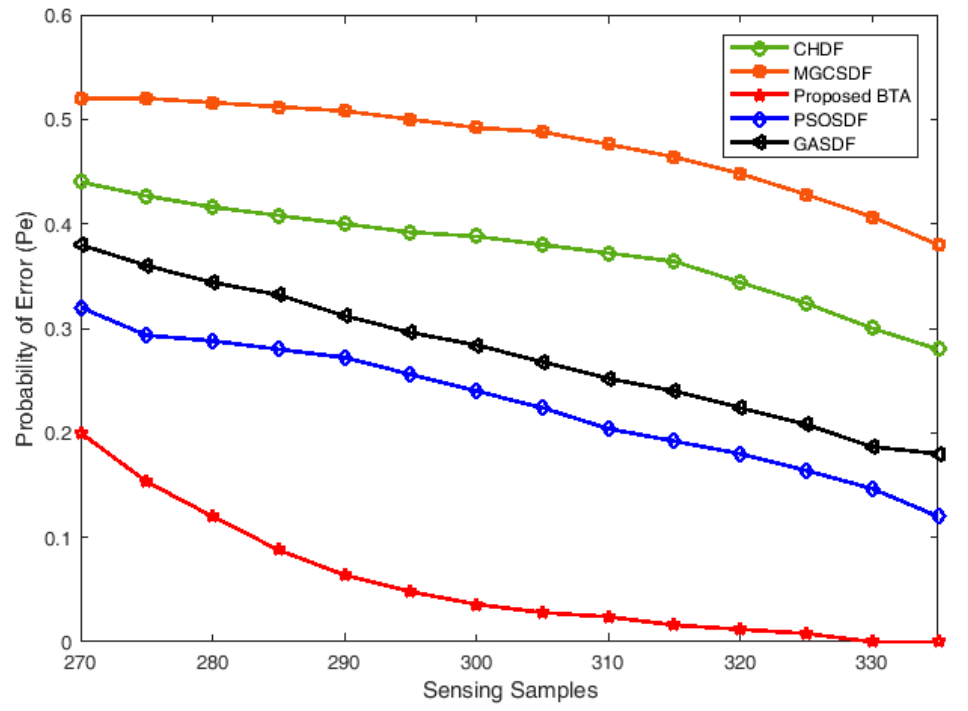
Figure 15. Probability of error vs. sensing samples under opposite users.